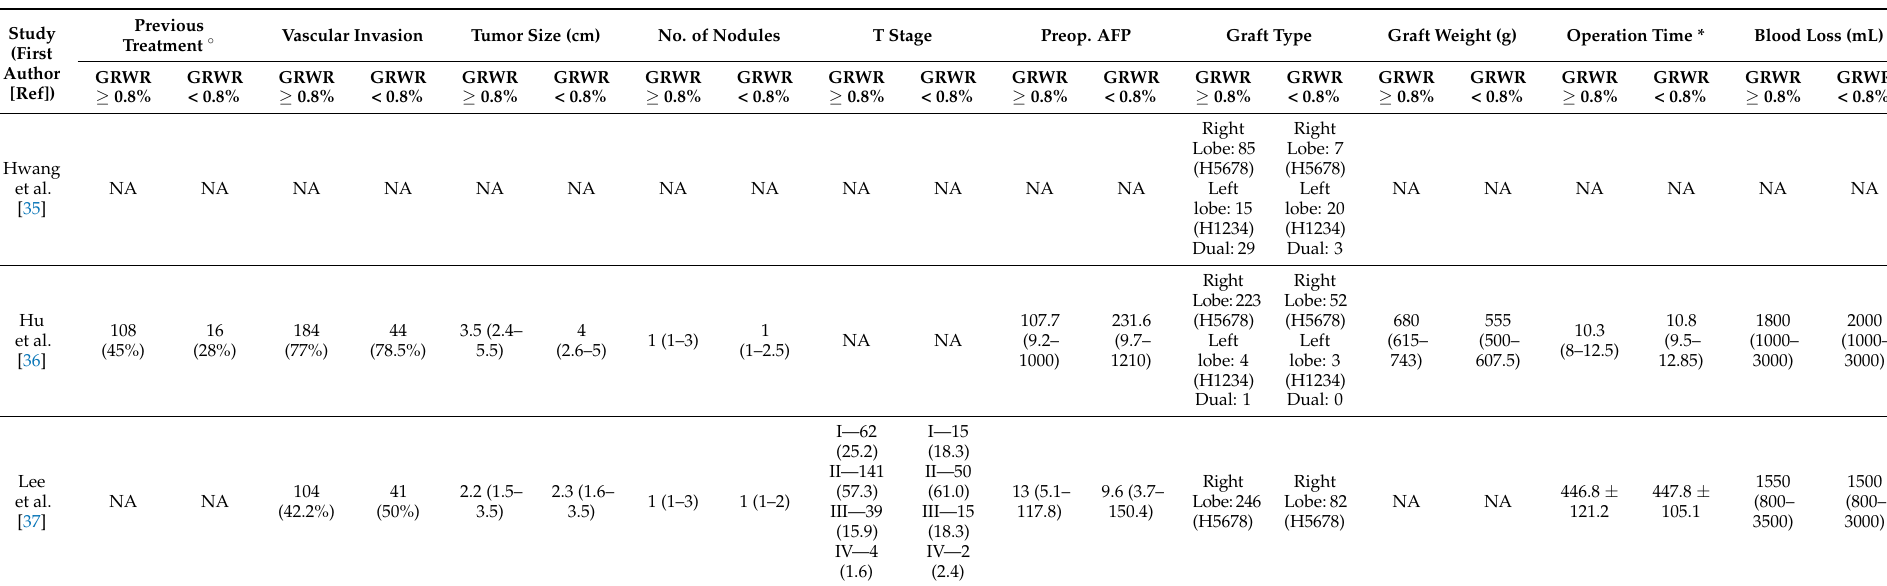
Table 3. Graft and tumor